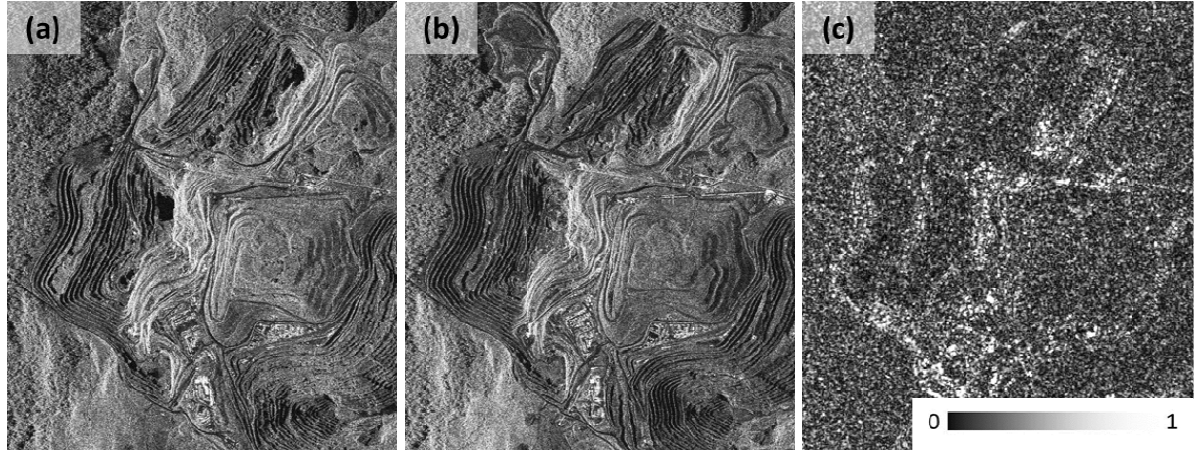
Figure 5. The figures depict the decorrelation effect of radar scenes over N4W iron mine: ( a ) and ( b ) amplitude scenes acquired on 20 March and 23 September 2012, respectively; and ( c ) coherence map derived from the SAR scenes. White areas indicate no surface changes while black areas indicate the opposite. For the locations of pits and mine waste piles refer to Figure 4b. Perpendicular baseline = 231.5 m. The pictures are in slant range